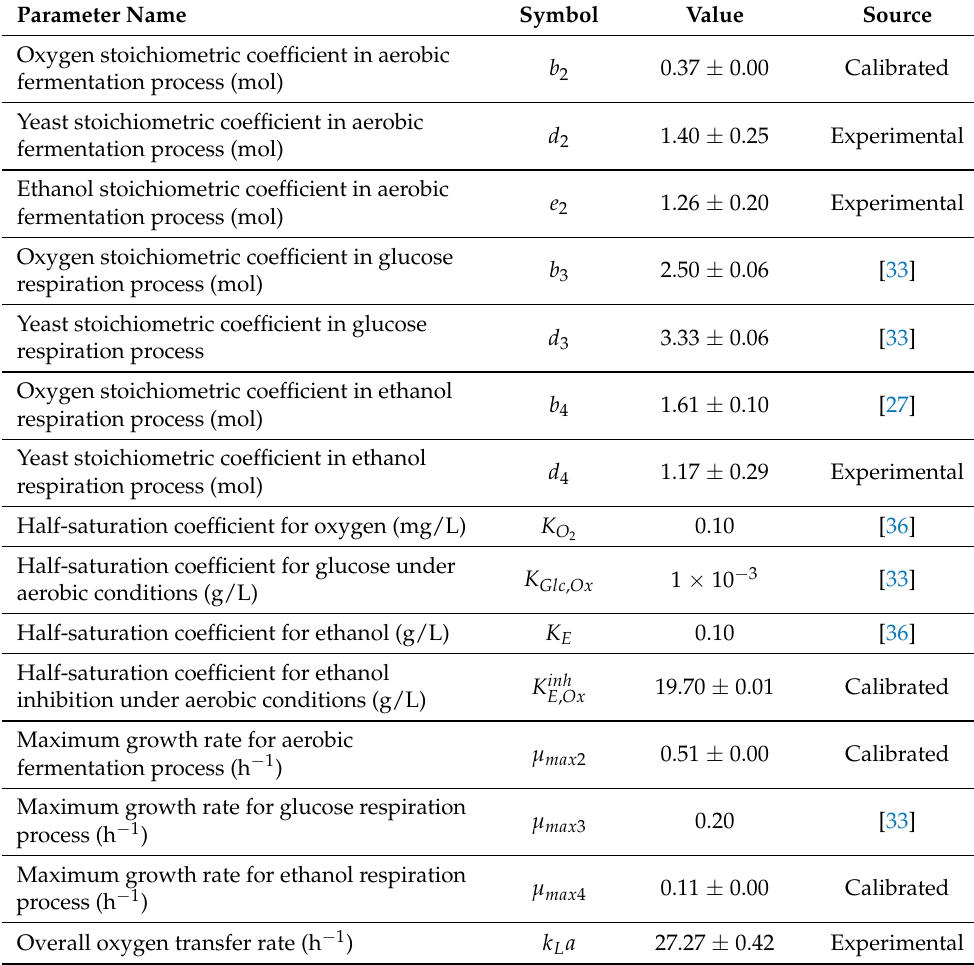
Table 5. Stoichiometry and kinetics parameters of the biological model under aerobic